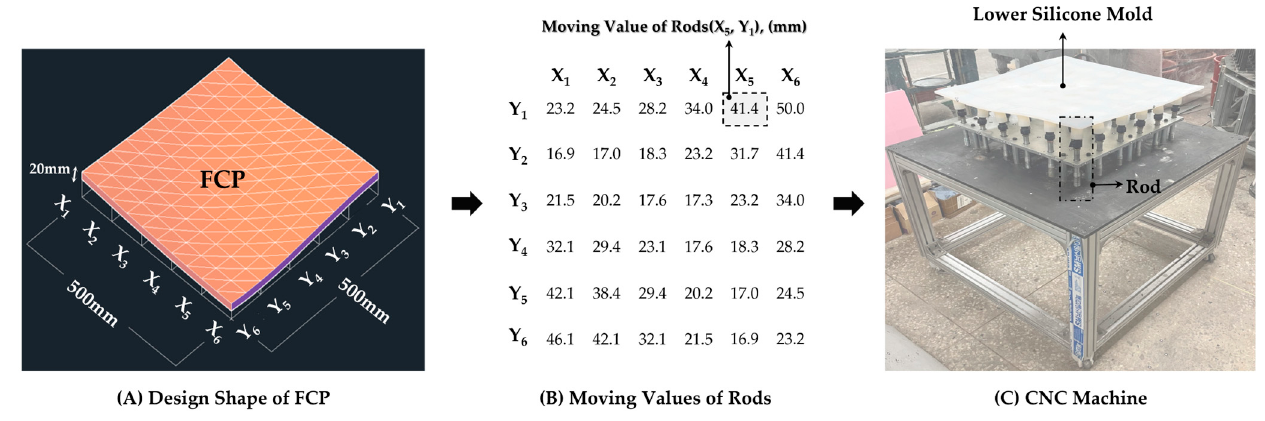
Figure 5. Design Data of FCP and CNC Machine.